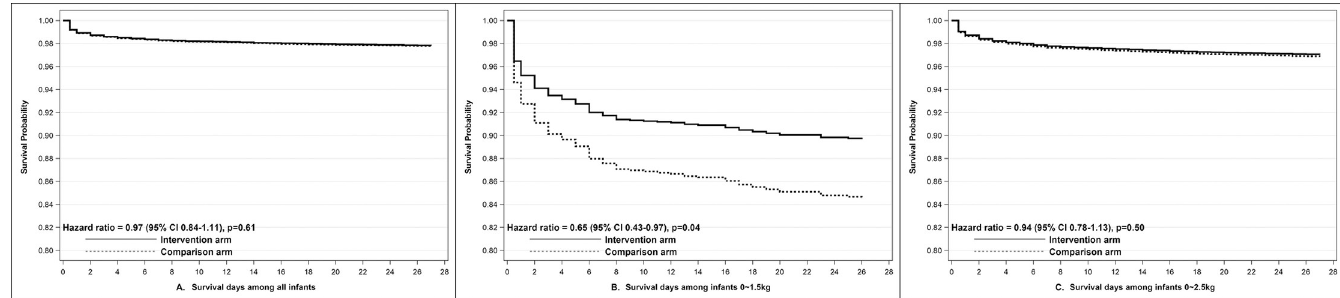
Fig 3. Kaplan–Meier survival curves showing treatment effect on survival time by intention-to-treat analysis for (A) all infants and subgroups of infants (B) � 1,500 g and (C) � 2,500 g. CI, confidence interval.